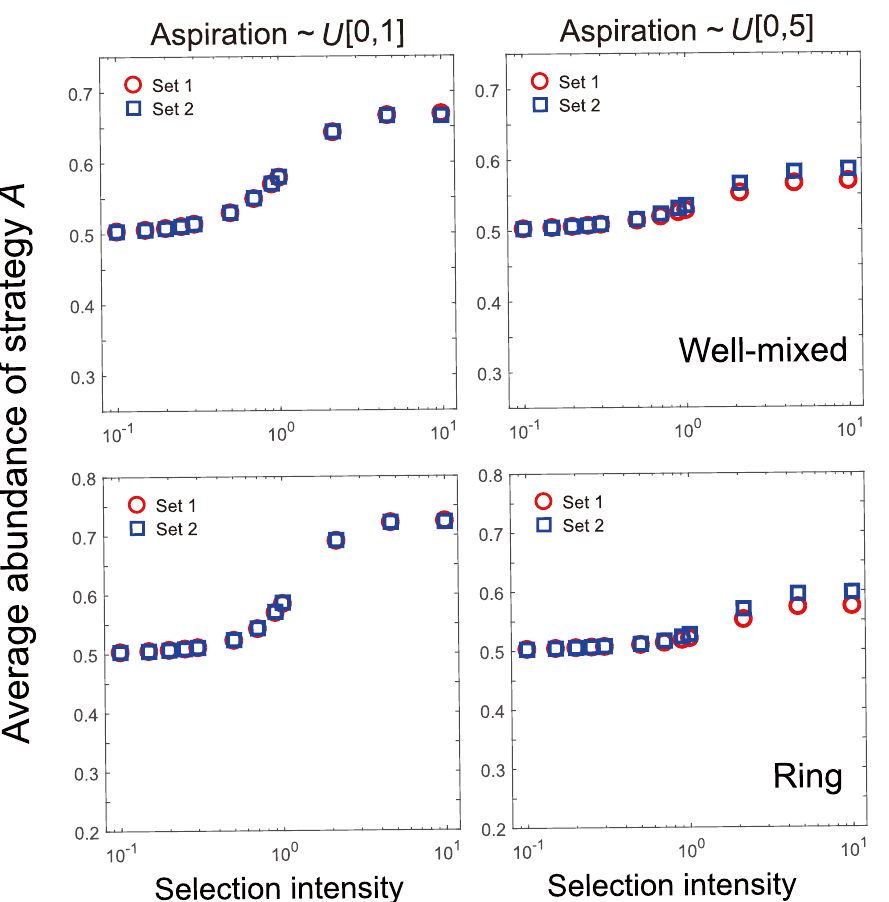
Fig 1. Average abundance of strategy A for a three-player game with individualised aspirations. Personal aspirations are randomly assigned based on a uniform distributions on the interval [0, 1] (left panels) or [0, 5] (right panels). Within each class, two sets of aspirations are assigned to represent two populations with different aspirations from the same distribution. In this way, we established two kinds of heterogeneity in aspiration: one resorts to the underlying distribution, and the other is based on the actual values sampled from the same distribution. Intuitively, both of the two heterogeneities would alter the evolutionary outcome. Simulations in line with our theorem, however, show that both kinds of the heterogeneity in aspiration lead to the identical abundance in A for both the well-mixed population (upper panels) and that on rings (lower panels). We illustrate other details of the simulation in the following. In well-mixed populations, the focal individual randomly chooses two individuals from the rest of the population, whereas it plays only with the nearest two neighbours on the ring. In the beginning, we randomly set 5% of the population to be of strategy A and the rest to be of strategy B . For each data point, it is the mean of 20 independent runs. In each run, we iterate the evolutionary process for 1 × 10 8 generations. The average abundance of strategy A is obtained by averaging abundance of strategy A over the last 5 × 10 7 generations. The population size N = 100. And the payoff entries are